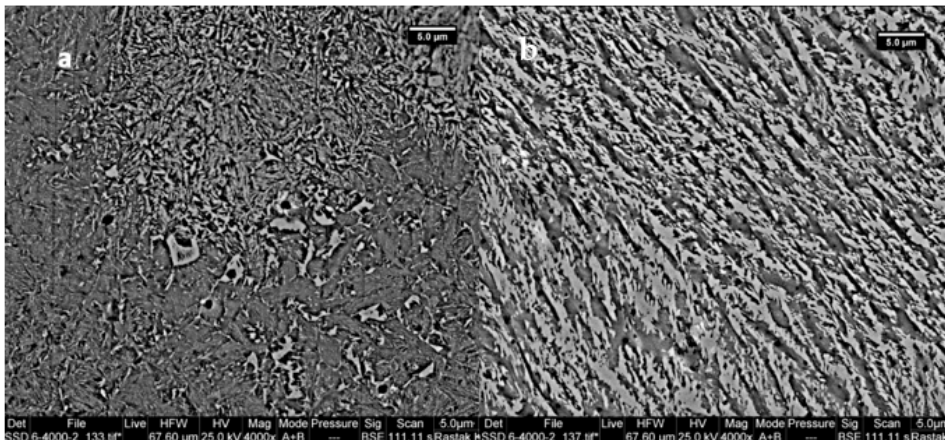
Figure 2. Microstructure of 1.6511: ( a ) standard composition and ( b ) optimized states by adding 2 wt% silicon. Note: The microstructure has changed from martensitic bainitic to CFB with the addition of silicon.